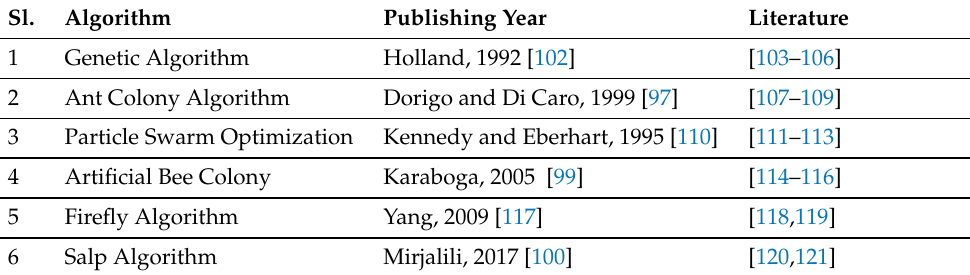
Table 2. Swarm based optimization